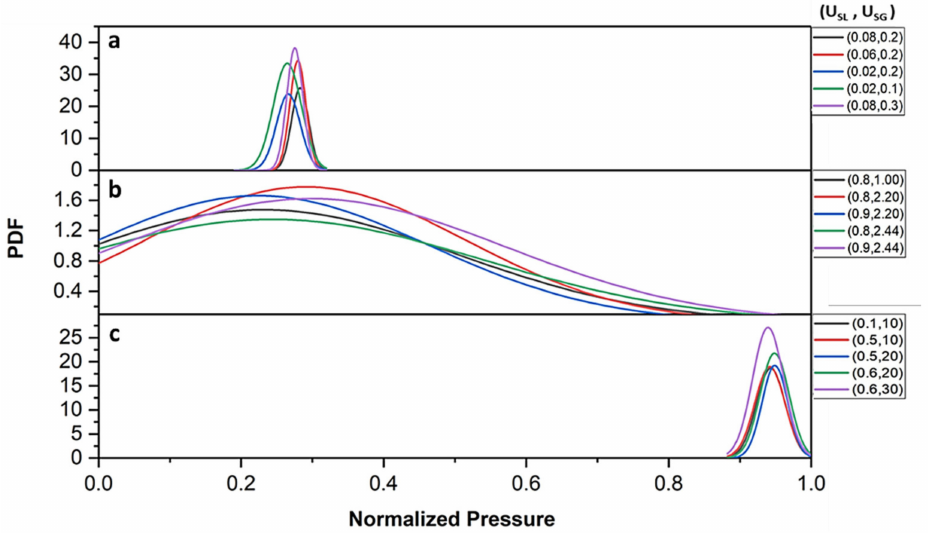
Figure 11. Probability Density Function for pressure signals of different flow regimes: ( a ) stratified, ( b ) slug, and ( c )